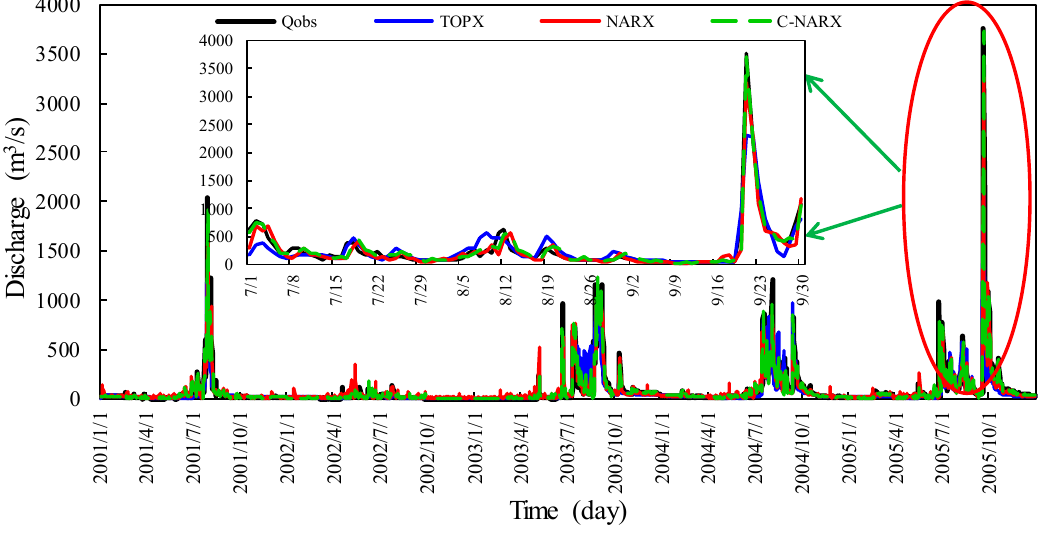
Figure 6. The comparison of runoff simulation results driven by the NARX, C-NARX and TOPX models in the training or calibration period.